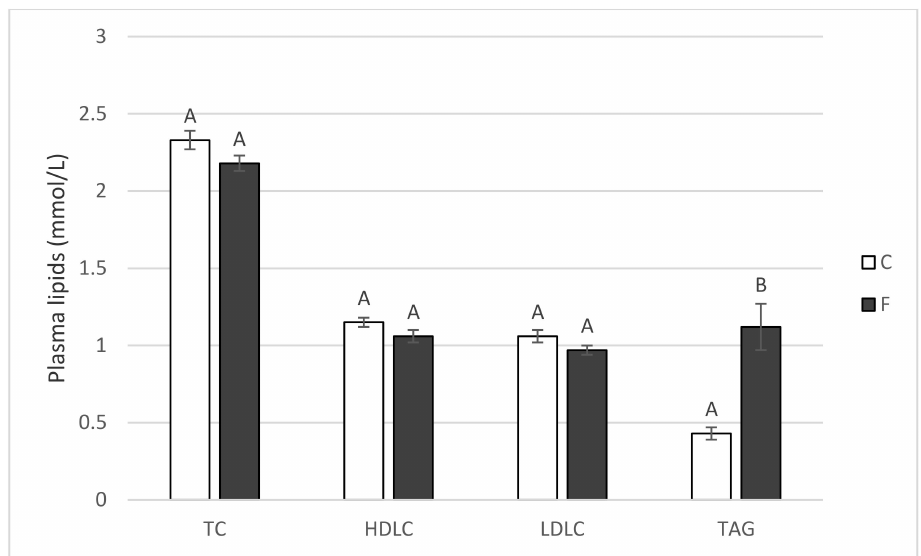
Figure 2. Concentration of total cholesterol (TC), high-density lipoprotein cholesterol (HDLC), low-density lipoprotein cholesterol (LDLC) and triacylglycerols (TAG) in the plasma of pigs fed for four weeks on either the control standard feed mixture (C) or feed mixture enriched with 8% fish oil (F). Means with di ff erent letters within the given parameter di ff er at p < 0.05 (independent groups t-test; n = 6).